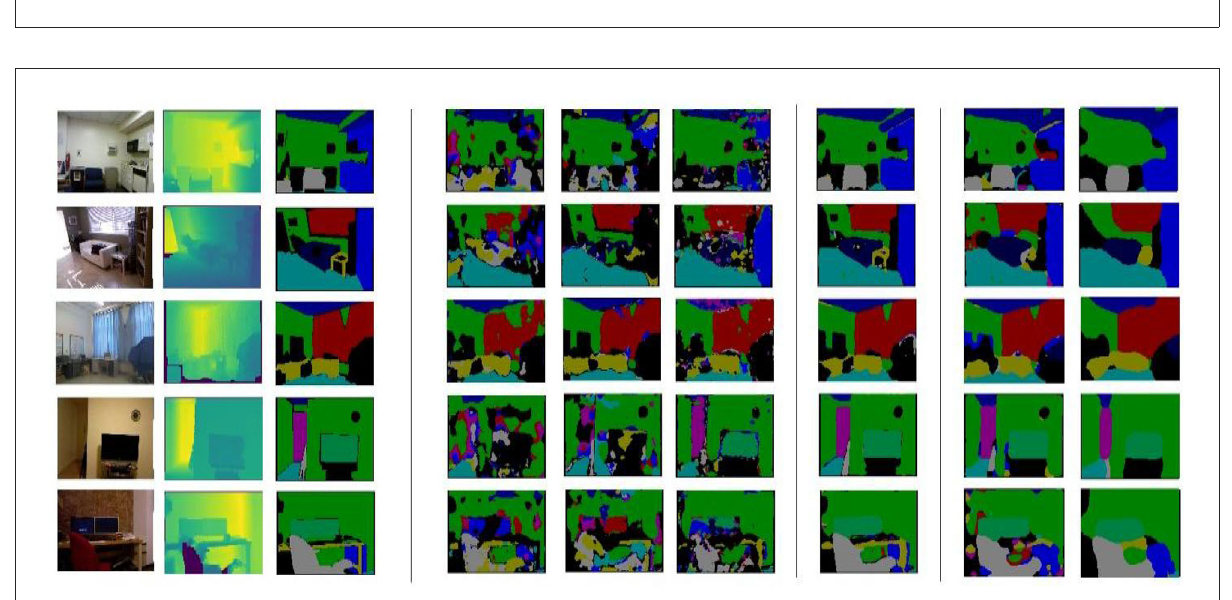
FIGURE11 Semantic segmentation results of the actual collected data.